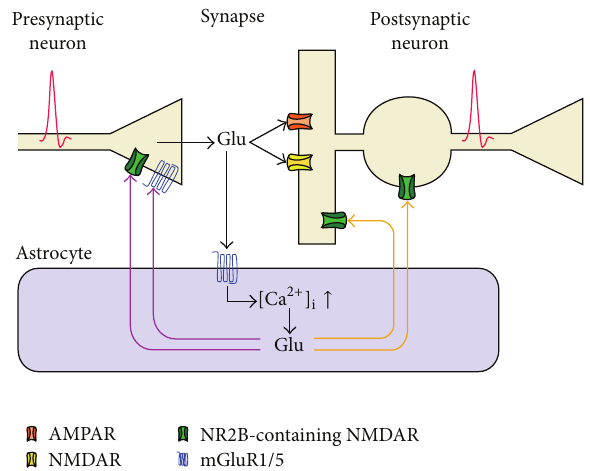
Figure 1: Pathways of glutamatergic gliotransmission. Perisynaptic astrocytic processes in several brain areas and different excita- tory (but also inhibitory) synapses may release glutamate in a Ca 2+ -dependent fashion. In turn, released astrocytic glutamate may increase (or decrease) synaptic neurotransmitter release by activating extrasynaptically located presynaptic receptors ( magenta arrows ) or contribute to postsynaptic neuronal depolarization by binding to extrasynaptic NMDA receptors ( orange arrows ) which mediate slow inward currents (SICs). These receptors often (but not always) contain NR2B subunits and are thus different with respect to postsynaptic NMDARs. Glutamate release by the astrocyte could be triggered either by activity from thesamesynapses that areregulated by the astrocyte (homosynaptic scenario) or by other synapses that are not directly reached by glutamatergic gliotransmission (heterosynaptic